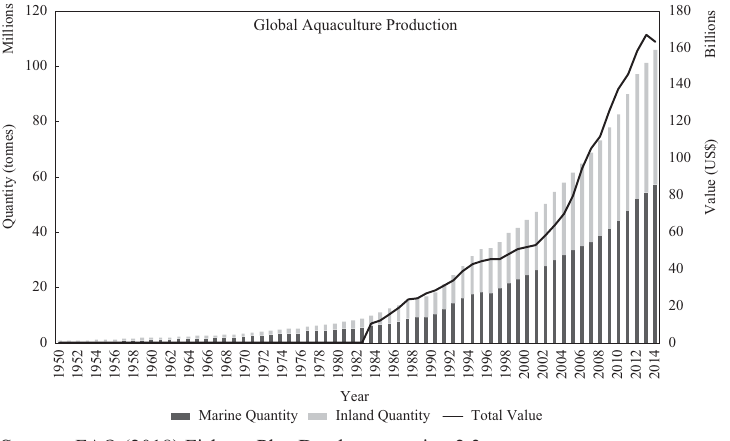
Figure 2. Global aquaculture production in quantity and total